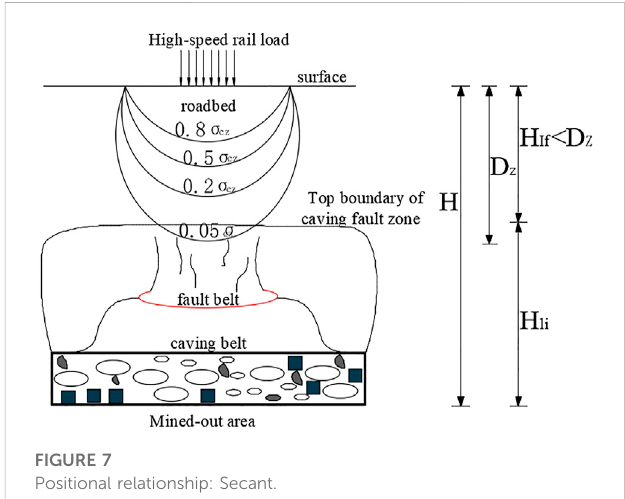
FIGURE 7 Positional relationship: